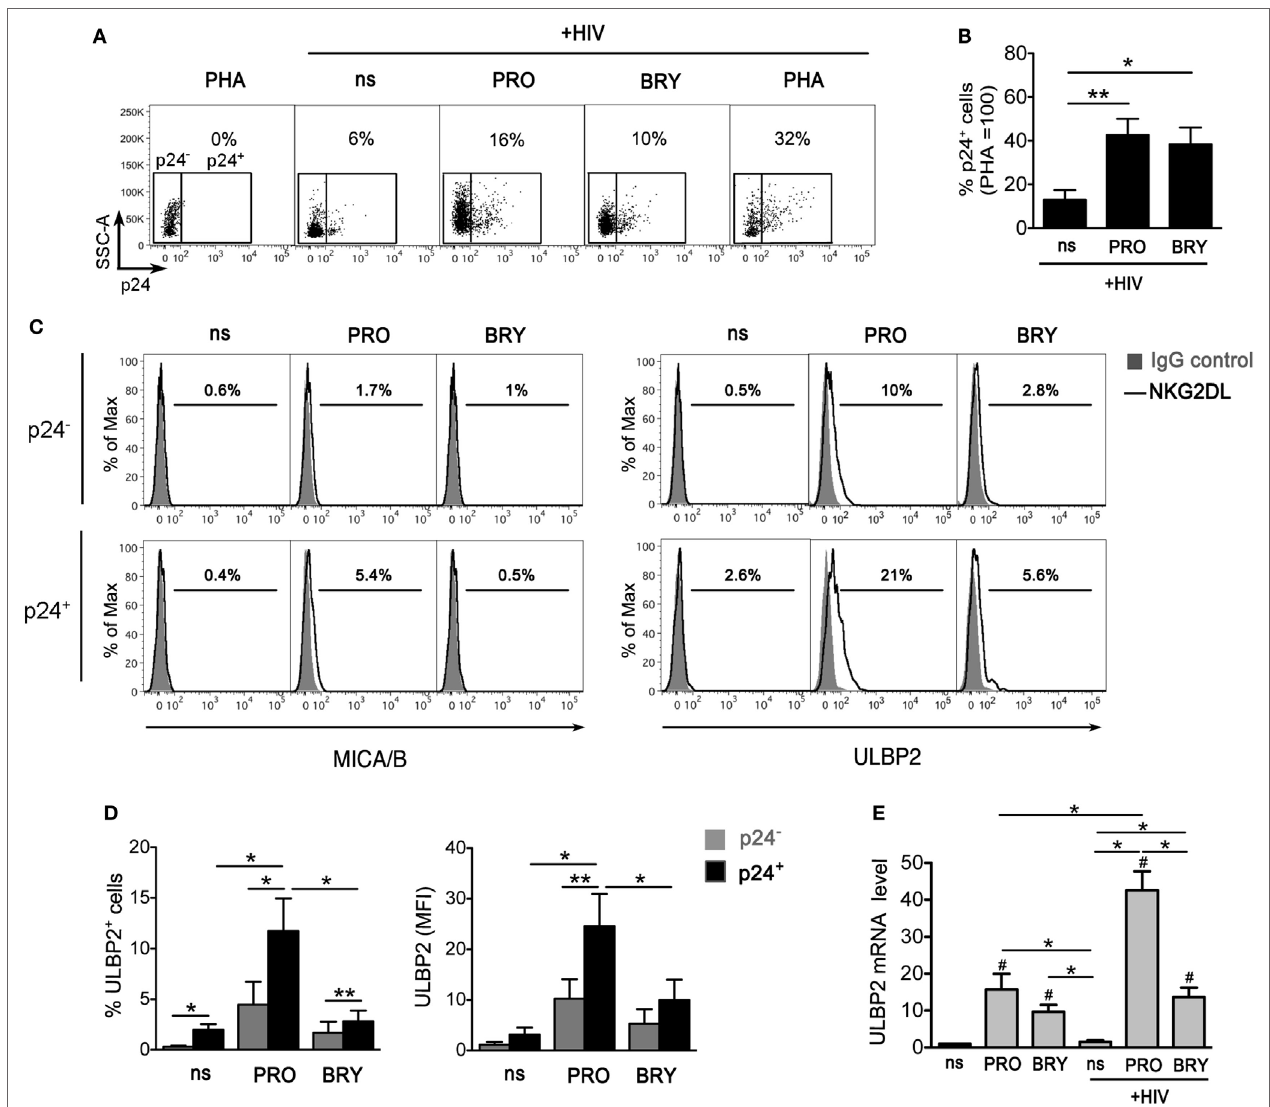
FigUre 4 | ULBP2 is induced on latently infected CD4 + T cells upon HIV-1 reactivation by prostratin (PRO) and, to a lesser extent, by bryostatin-1 (BRY). To establish viral latency, freshly isolated CD4 + T cells were cultivated in the presence of CCL19 for 1–3 days, infected or not with HIV-1, and further cultured for 3 days, as described in details in Section “Materials and Methods.” Then, cells were stimulated with 10 µg/ml phytohemagglutinin (PHA), 1 µM PRO, or 10 nM BRY, or not stimulated (ns), further cultivated for 3 days and finally analyzed by two-color flow cytometry for the expression of intracellular p24 and cell-surface MICA/B and ULBP2. (a) Representative dot plots show the frequency of reactivated p24 + cells gated on non-infected PHA-stimulated control cells. (B) Percentage of p24 + cells was determined as shown in panel (a) in four independent experiments and normalized to HIV-infected PHA-treated cultures (mean ± SEM). (c) Histograms show MICA/B and ULBP2 fluorescence in the gated p24 − (top panels) and p24 + (bottom panels) cell populations measured in a representative experiment on ns, PRO- and BRY-stimulated cell samples. Signals obtained with control IgG (filled histograms) and the percentage of ligand-positive cells are shown. (D) ULBP2 expression (mean ± SEM), both% of positive cells and mean fluorescence intensity (MFI), was determined as shown in panel (c) in four independent experiments. (e) RT-qPCR was used to assess ULBP2 mRNA levels in latently infected and in control non-infected CD4 + T cells cultivated for 24 h in ns, PRO, and BRY conditions. Results are expressed relative to ns non-infected sample (set to 1). Mean ± SEM values obtained in three independent experiments performed in duplicate are shown. * P < 0.05 and ** P < 0.01 by paired t test. Values that differ significantly from ns non-infected samples in panel (e) are also indicated ( # P < 0.05 by paired t